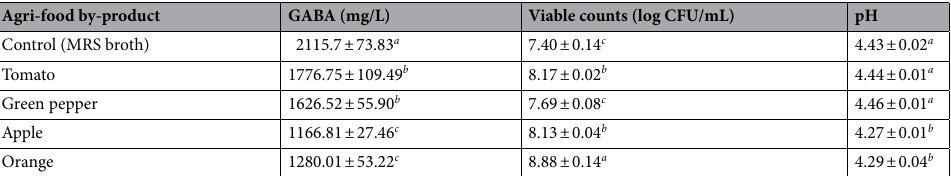
Table 3. Content of GABA (mg/L), viable counts (log CFU/mL) and pH values achieved with L. plantarum K16 fermenting tomato, green pepper, apple, and orange by-products and MRS broth as a control (Different letter superscripts indicate if the results are statistically significant ( P ≤ 0.05) in the GABA content, viable counts, or pH values among the agri-food